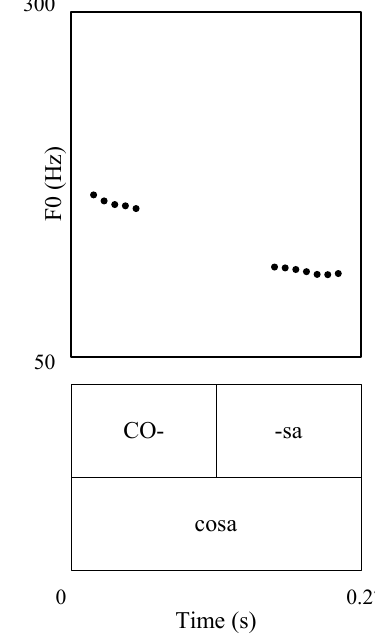
Figure 5. Open cosa ‘what’ produced by Mirko in Extract